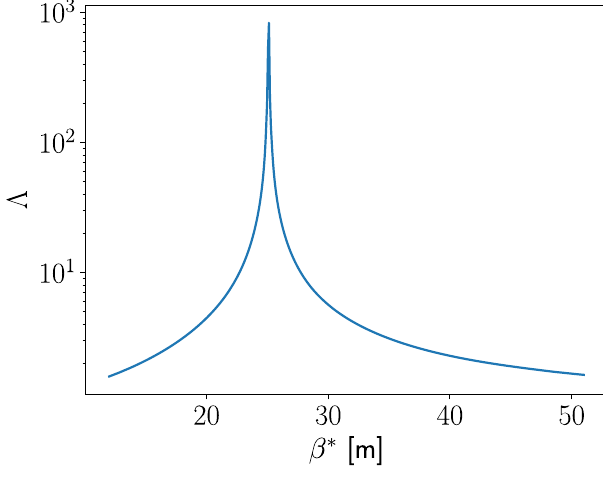
FIG. 3. Difference between the two solutions given by Eq. (8) as a function of β (cid:1) . = 2 ¼ 2 . 1 m. Q